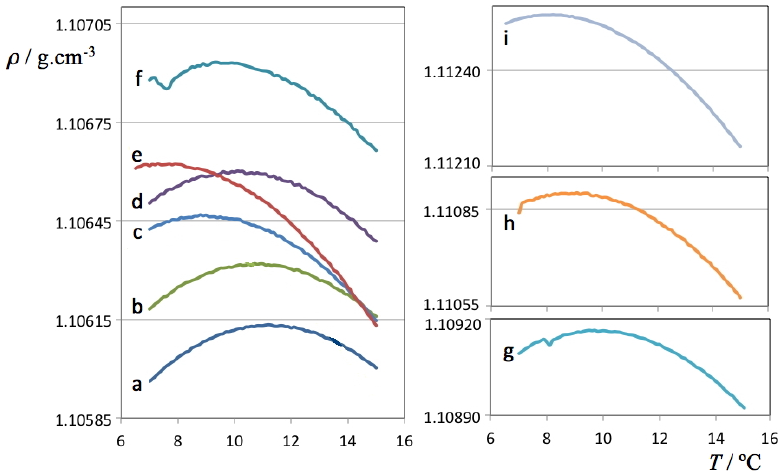
Figure 2. Density as a function of temperature for each of the studied ionic liquid aqueous (D O) solutions. The a label refers to pure deuterated water, the b-i labels refer to the D 2 solutions listed in Table 2.